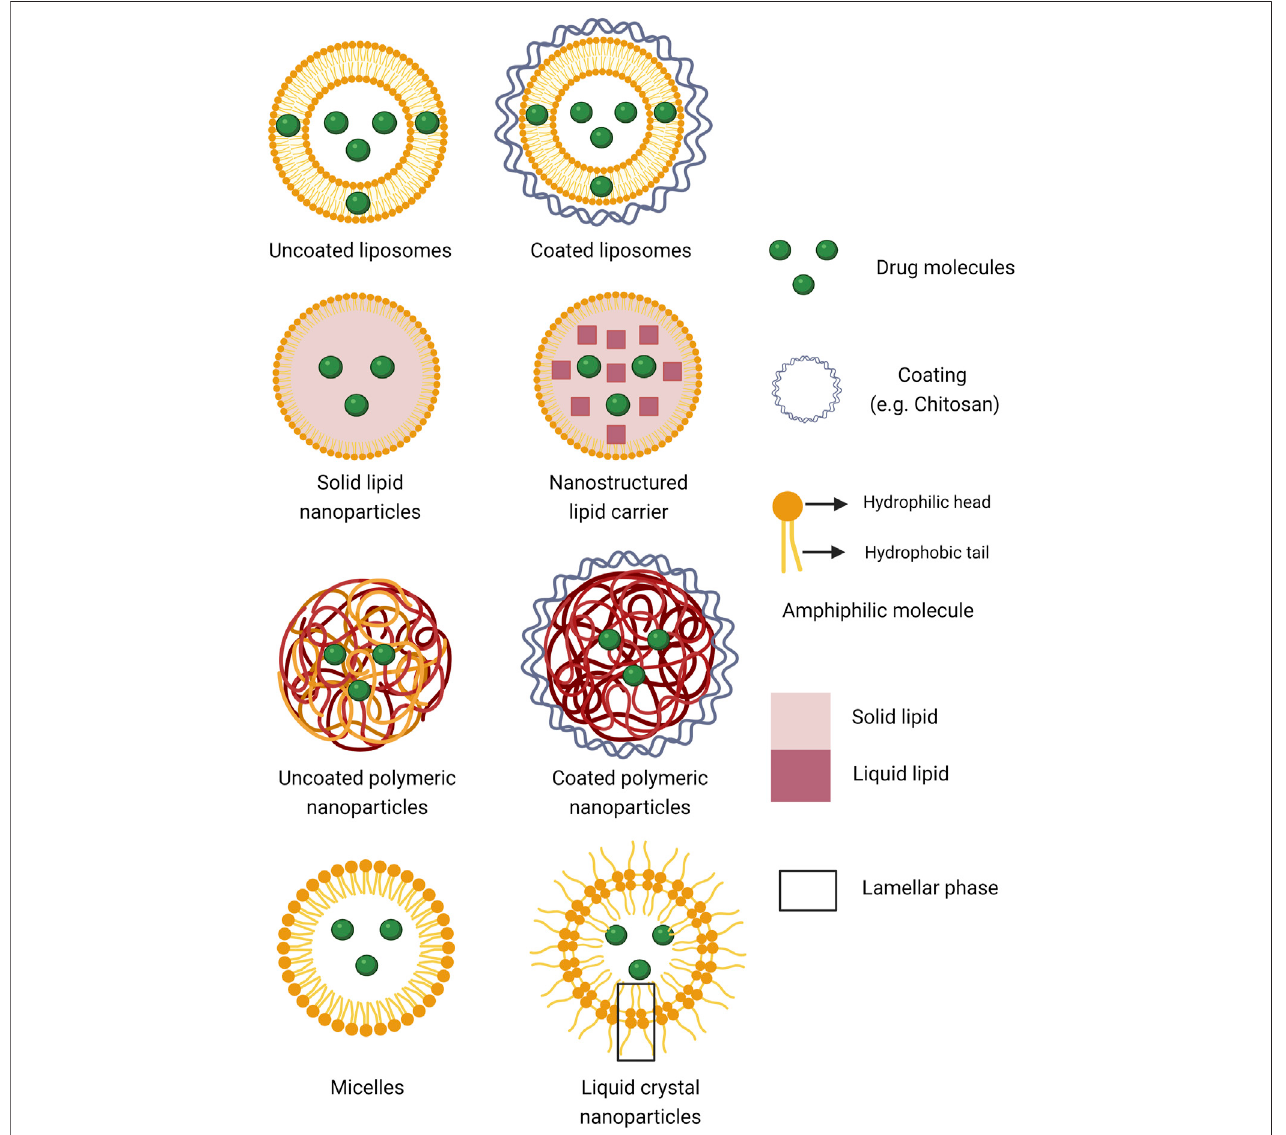
FIGURE 1 | Schematic presentation of the different types of nanoparticulate systems for drug encapsulation scrutinized in the present analysis (Created with BioRender.com).